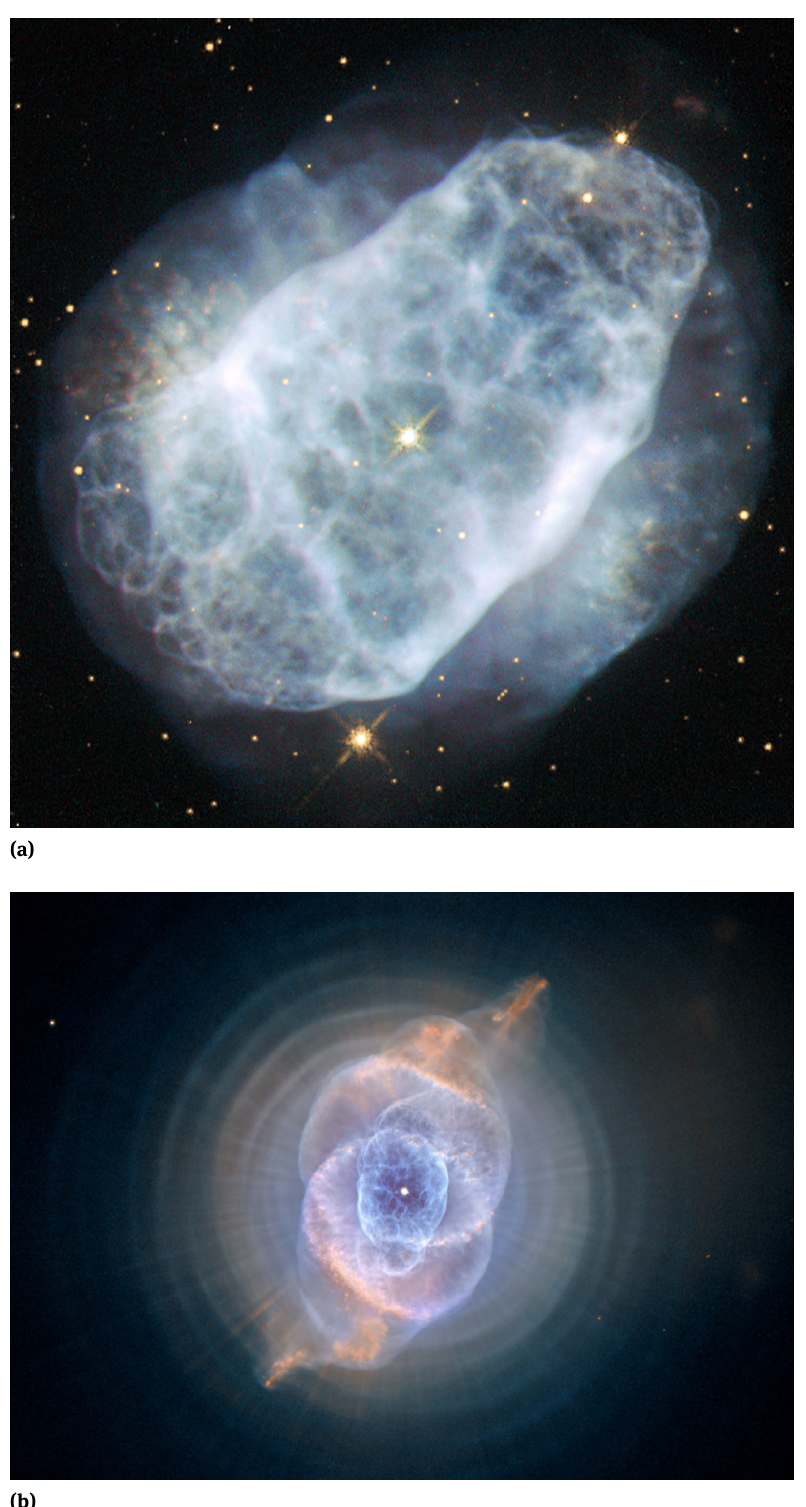
Figure 3. (a) The NGC 6153 is a metal-rich planetary nebula (the image is credited from ESA/Hubble); (b) Cat’ Eye Nebula (NGC 6543) contain- ing relatively high abundance of metallic composition such Mg and Fe (the image is credited from